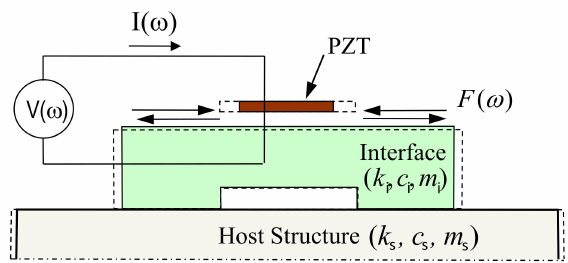
Figure 1. PZT (lead–zirconate–titanate) interface-host structure interaction under voltage